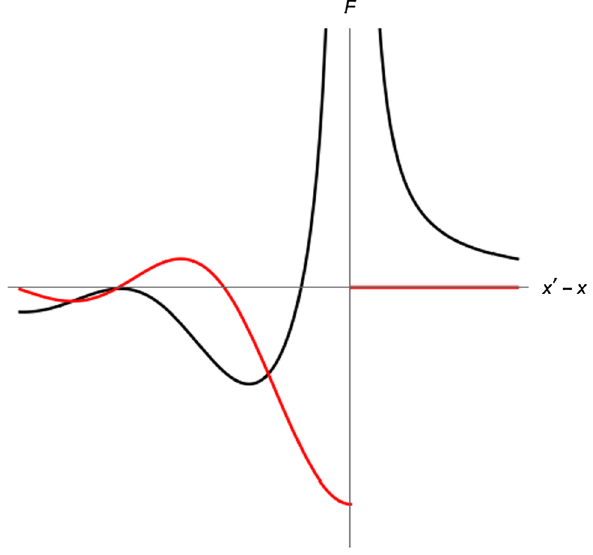
Fig. 2 F as a function of x (cid:12) − x , and for a fixed γ ; the black curve represents therealpart;theconventional i -imaginarypartisrepresented by the red curve. Both curves are no continuous at x (cid:12) − x = 0